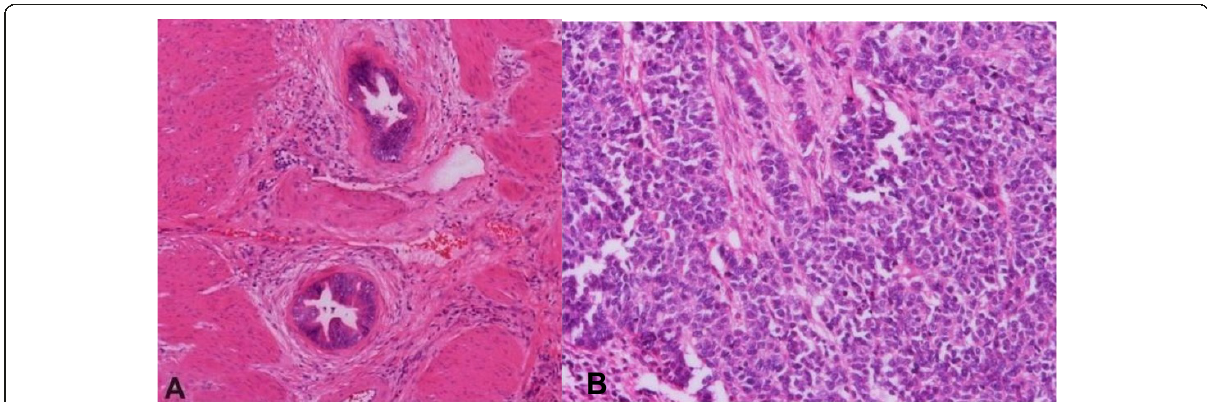
Figure 5 Mixed types of GBC present difficulty with differential diagnosis . A: Gallbladder tumor showing well-differentiated tubular adenocarcinoma in the muscle (H&E stain, X100), B: A monotonous proliferation of small round cells with hyperchromatic nuclei and scant cytoplasm, resembling NEC (H&E stain,